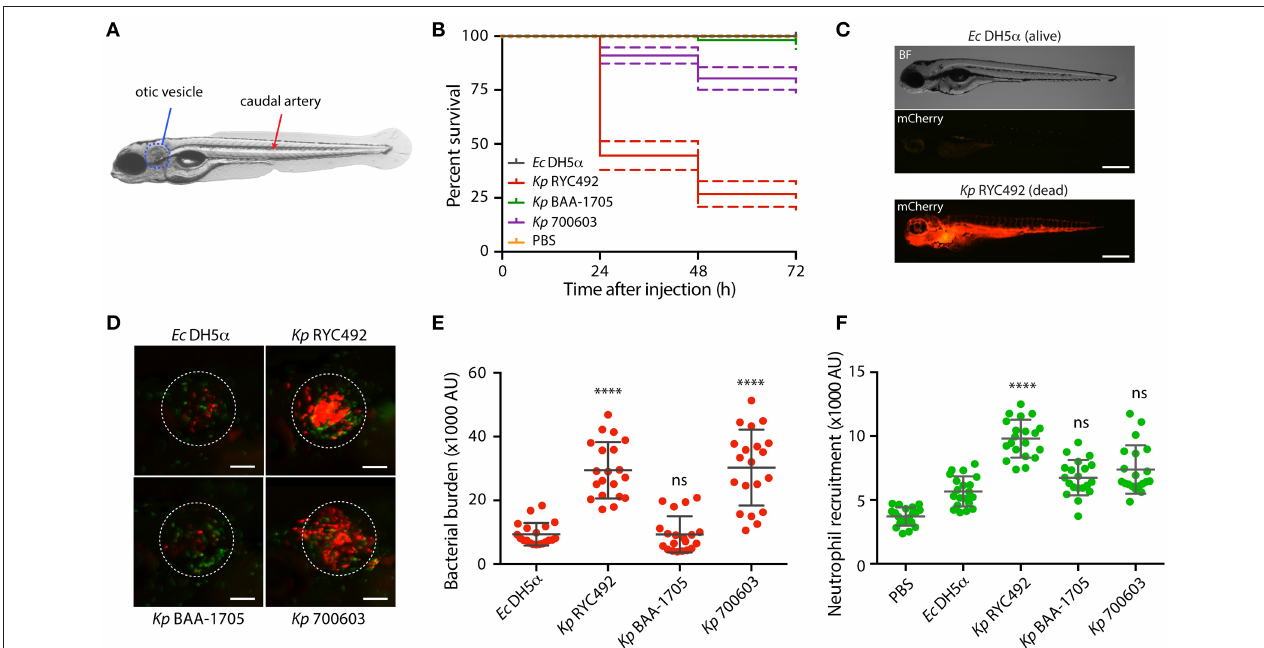
FIGURE 4 | K. pneumoniae strains show different virulence behavior in the zebrafish larvae as revealed by survival curves and neutrophil recruitment. (A) Scheme of a 5-dpf zebrafish larva. Bacteria were injected in the dorsal caudal artery (red arrow) for establishing a rapid systemic infection, or in the otic vesicle (blue circle) for a localized infection. (B) Kaplan-Meier survival curves following injection of 3 dpf larvae with various strains of K. pneumoniae or with E. coli DH5 α as a control. Larvae survival was monitored for 3 days after injection. The data are representative of three independent experiments, with a total of 57 larvae per bacterial strain. (C) Representative picture of a larva infected for 24h with K. pneumoniae RYC492 strain, after acute bacteremia and death, and an unaffected larva injected with E. coli as a control. Bacteria expressing mCherry fluorescent protein is shown red. Scale bar, 500 µ m. (D) Neutrophils attracted to the otic vesicle of Tg( BACmpo:gfp ) zebrafish larvae injected with K. pneumoniae strains or E. coli DH5 α after 24h post-injection (hpi). Bacteria are red and neutrophils are green. The white dashed lines encircle the otic vesicle. Scale bar, 100 µ m. (E) Bacterial burden in the otic vesicle of zebrafish larvae after 24 hpi. Measurements of red fluorescence from mCherry-labeled bacteria are plotted as arbitrary units (AU) for each K. pneumoniae strain or for E. coli DH5 α . The data are representative of three replicates, with a total of 21 larvae per condition. (F) Neutrophils infiltrated in the otic vesicle of Tg( BACmpo:gfp ) zebrafish larvae after 24 hpi. Measurements of green fluorescence from EGFP-labeled neutrophils are plotted as arbitrary units (AU) for larvae injected with K. pneumoniae strains, E. coli DH5 α , or PBS. The data are representative of three independent experiments, with a total of 21 larvae per bacterial strain. Error bars represent the standard deviation among the replicates. Statistical differences compared to E. coli DH5 α were assessed using a Kruskal-Wallis analysis followed by Dunn’s multiple comparisons test. **** p < 0.0001.